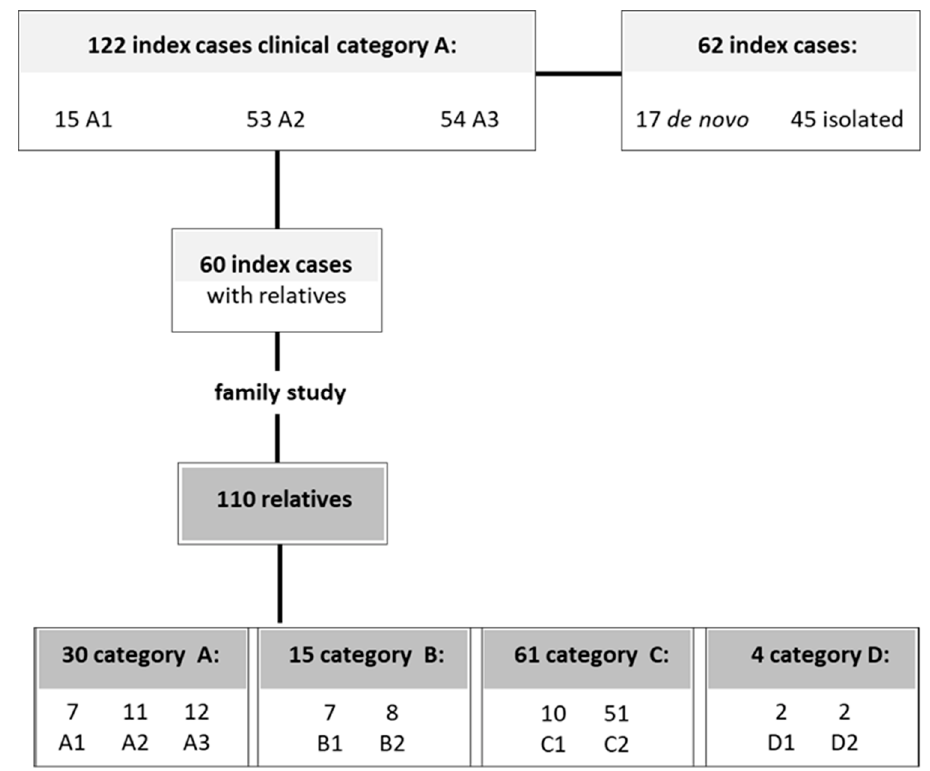
Figure 8. Patients recruitment and their clinical